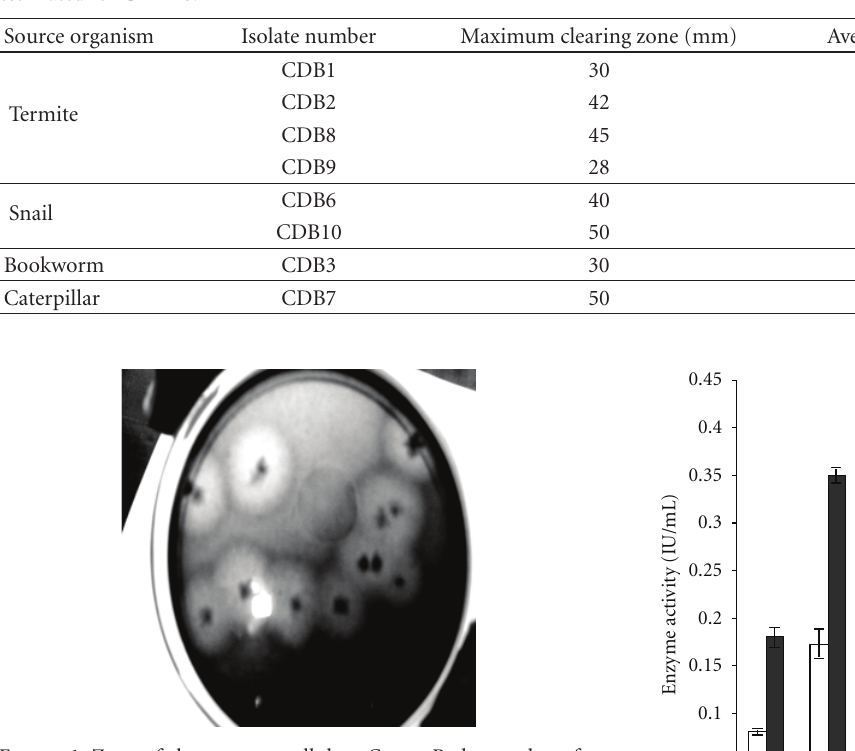
Figure 1: Zone of clearance on cellulose Congo Red agar plates for isolate CDB 10 after 48 hrs of incubation. The formation of clearing zone around the colonies confirms the secretion of extracellular cellulase.